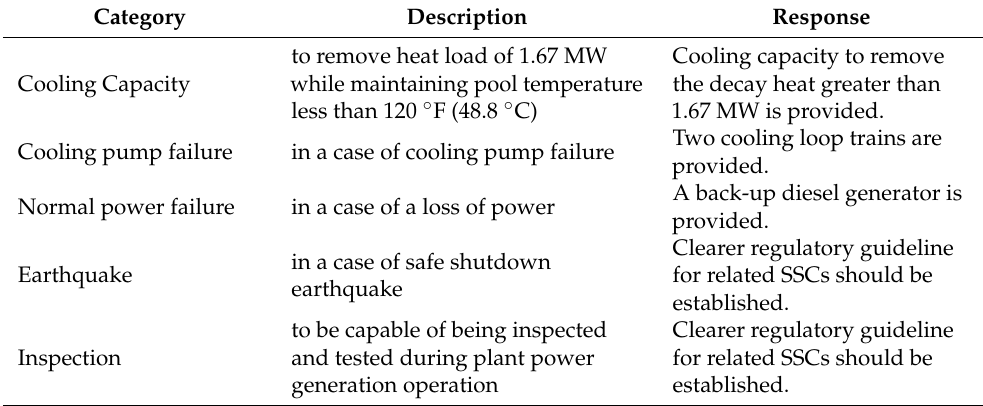
Table 11. System requirements for proposed temporary SFP cooling system.